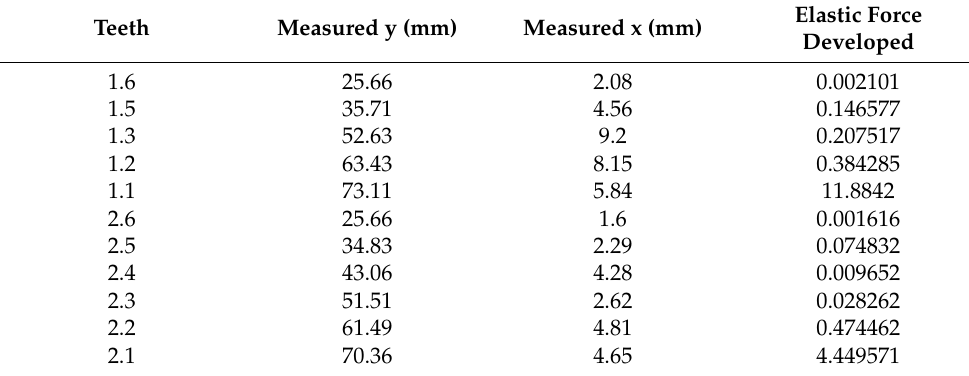
Table 9. The x and y coordinate values for the upper wire.